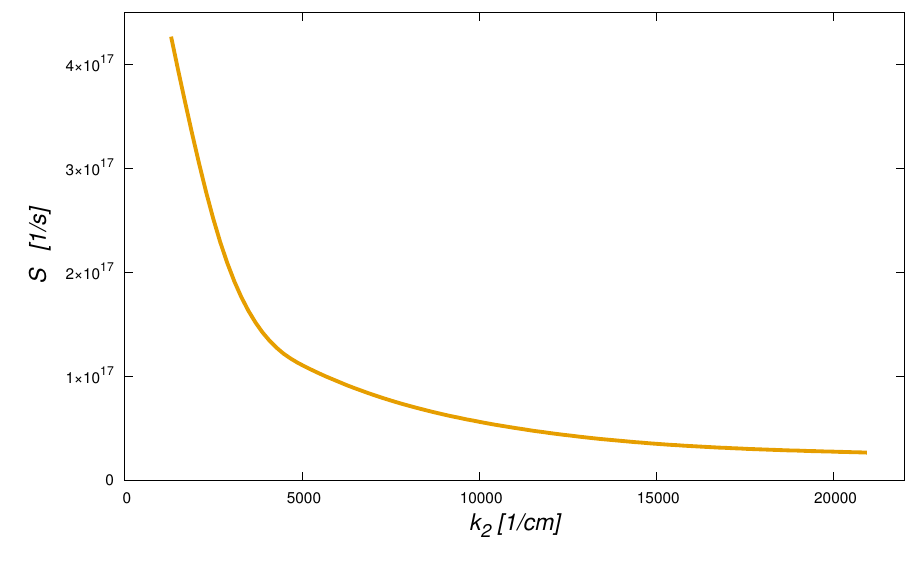
Figure 4. 1/ k -structure of the CI (65) of the annihilation channel that was obtained as the result of direct numerical calculations ( k 1 = 0, t = 100 a / v F )